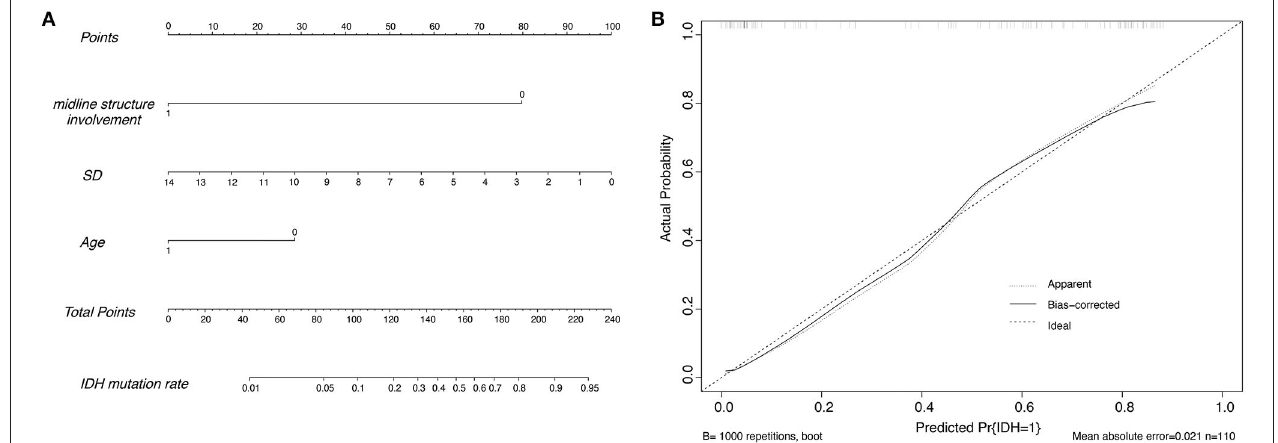
FIGURE 1 | (A) The nomogram developed in the whole cohort using the SUV SD metric, the age, and the brain midline structure involvement of the patients. 0 represents ≤ 45 years for age or without brain midline structure involvement and 1 represents > 45 years for age or with brain midline involvement, respectively; SD =